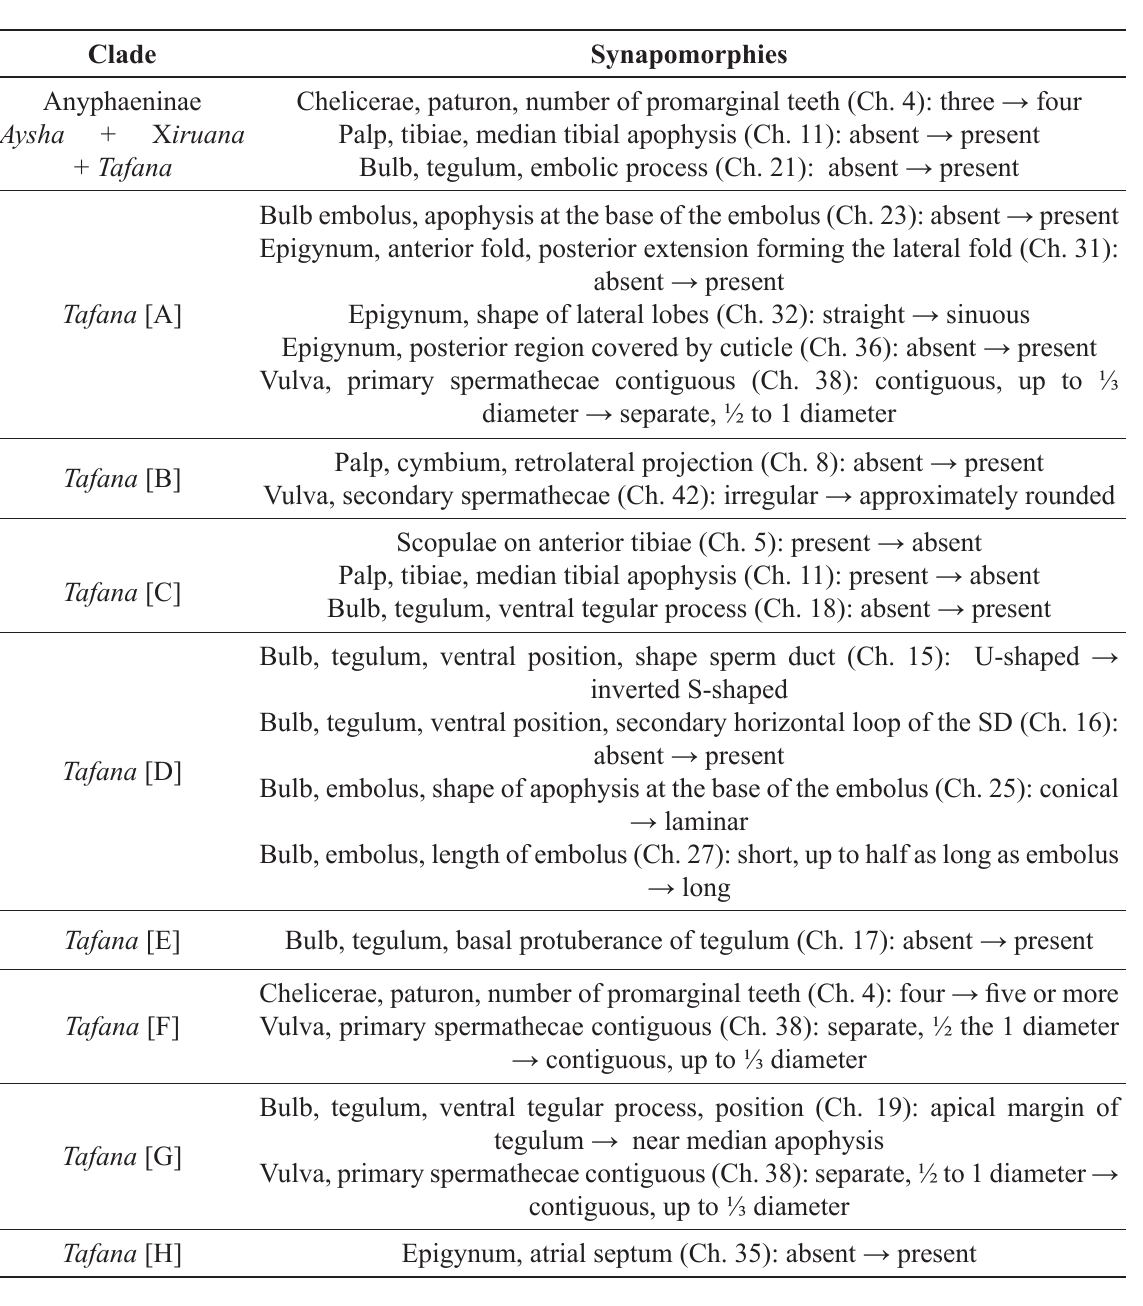
Table 2. Non-homoplastic and homoplastic synapomorphies supporting the main relationships within the clades Anyphaeninae and Tafana (see Fig.